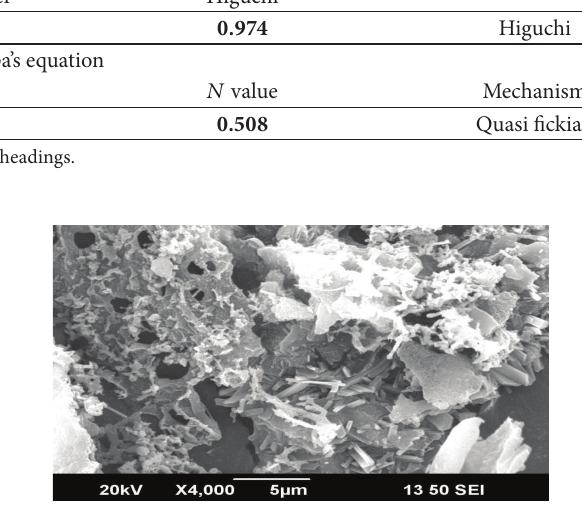
Figure 8: SEM image of optimized formulation (F3).